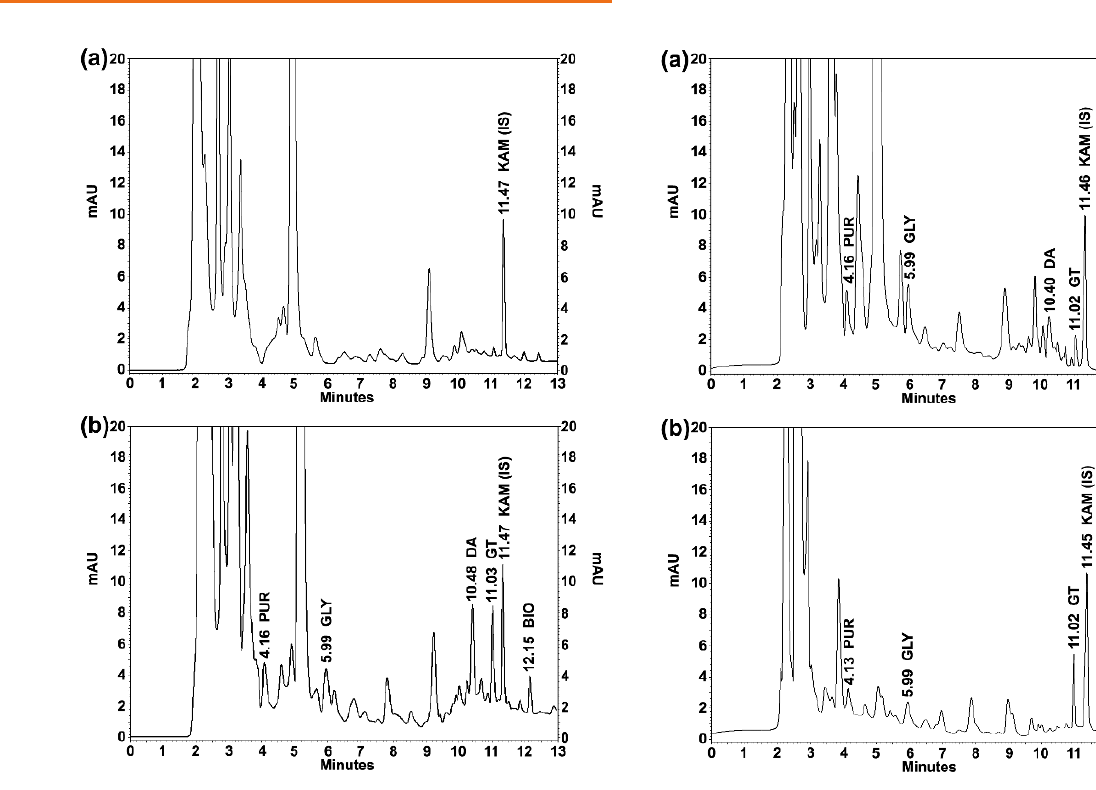
Figure 7. The chromatograms of (a) urine and (b) plasma sample from patients being on a diet rich in isoflavones and orally administered tablets containing the